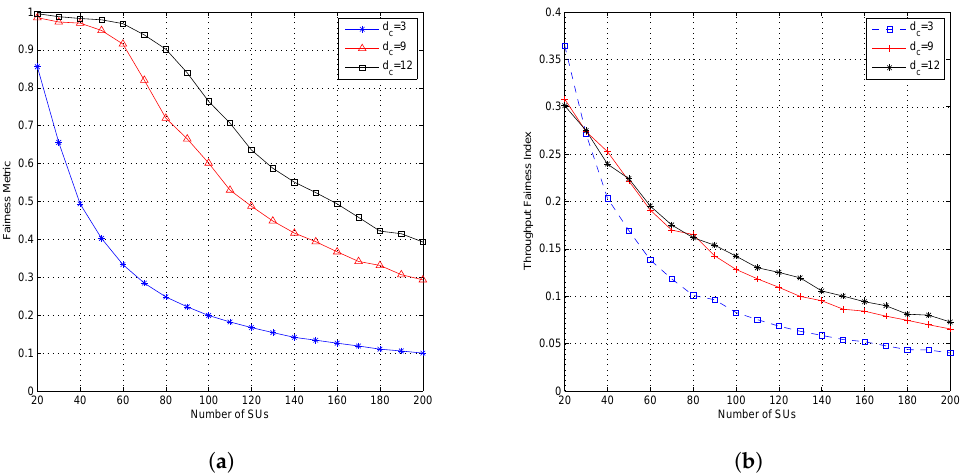
Figure 8. Performance of the proposed algorithm with variation of the value of d c and fixed d v ( d v = 12); ( a ) fairness metric and ( b ) throughput fairness